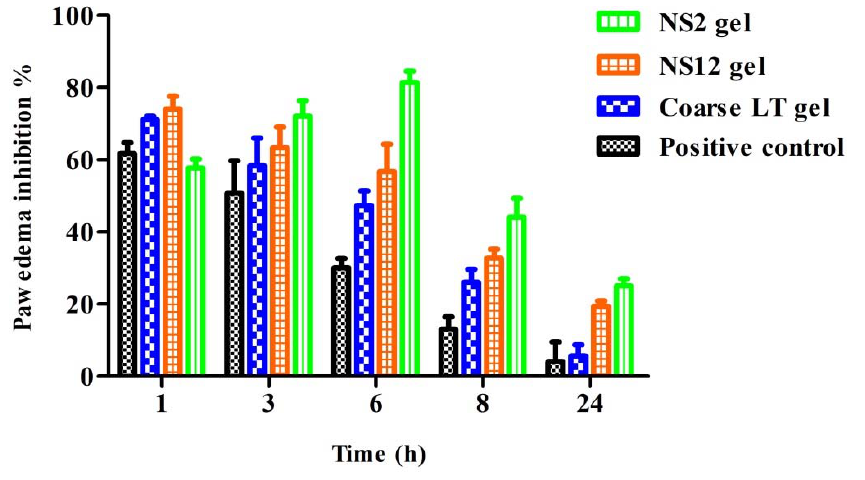
Figure 9. Percentages of paw edema inhibition versus time after topical application of NS2, NS12, and coarse LT gels (mean values ± SD, n = 6).